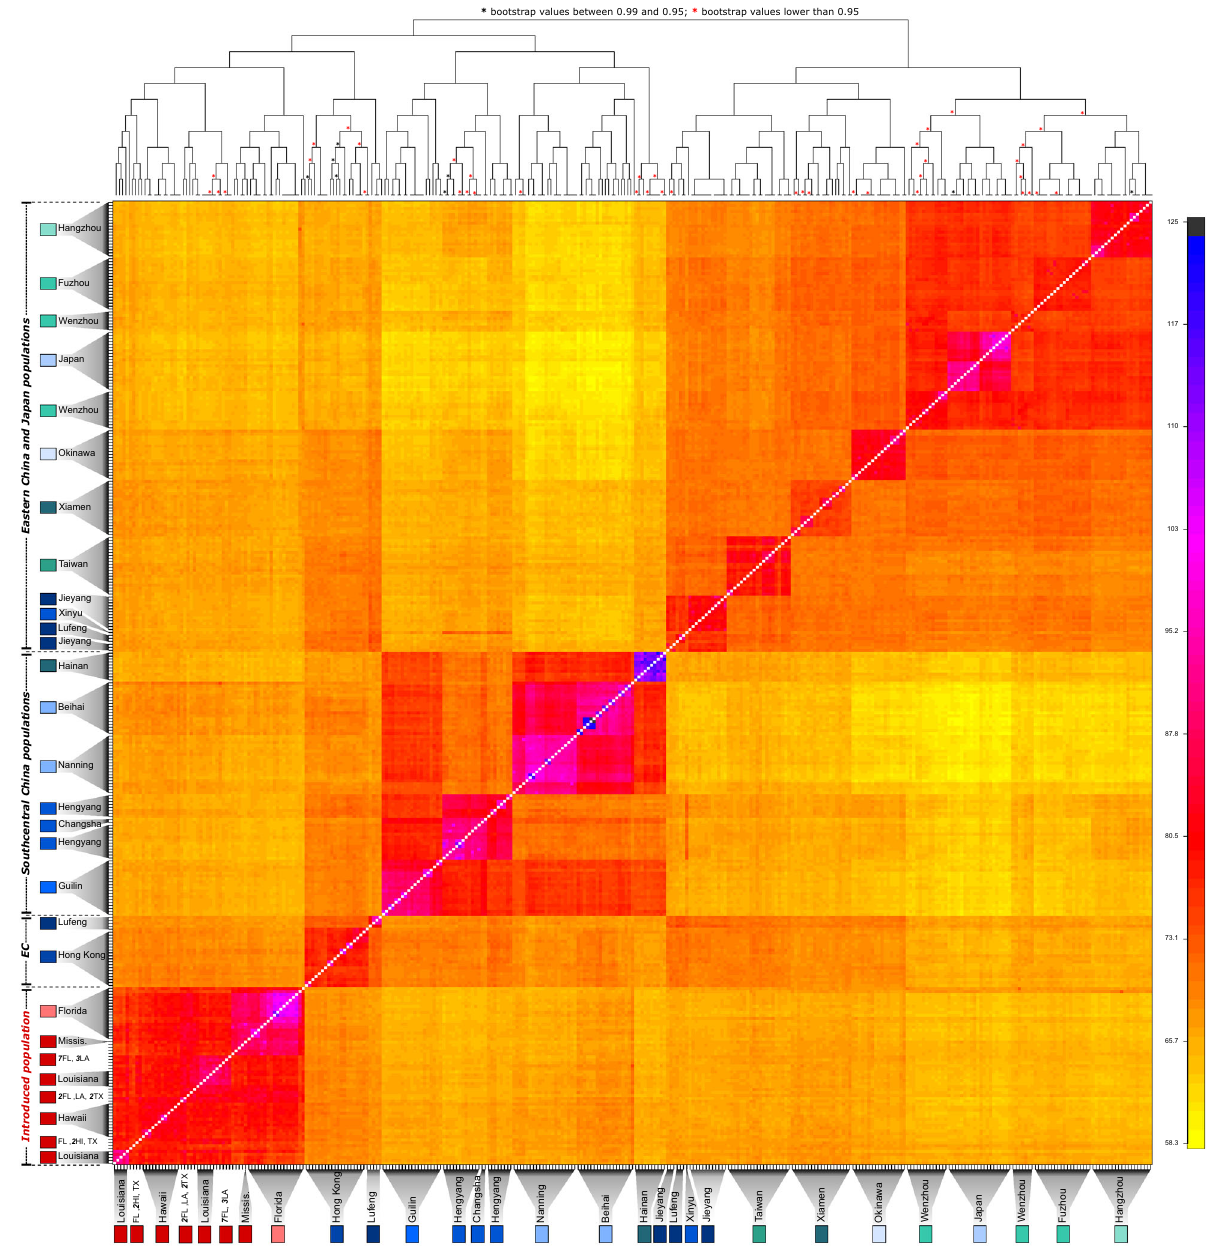
Fig. 3 fi neRADstructure analysis of C. formosanus . Co-ancestry matrix between each pair of individuals inferred using fi neRADstructure. Each pixel represents the individual co-ancestry coef fi cient between two individuals. Low co-ancestry coef fi cient values are depicted by yellow colors, whereas high values are indicated by darker